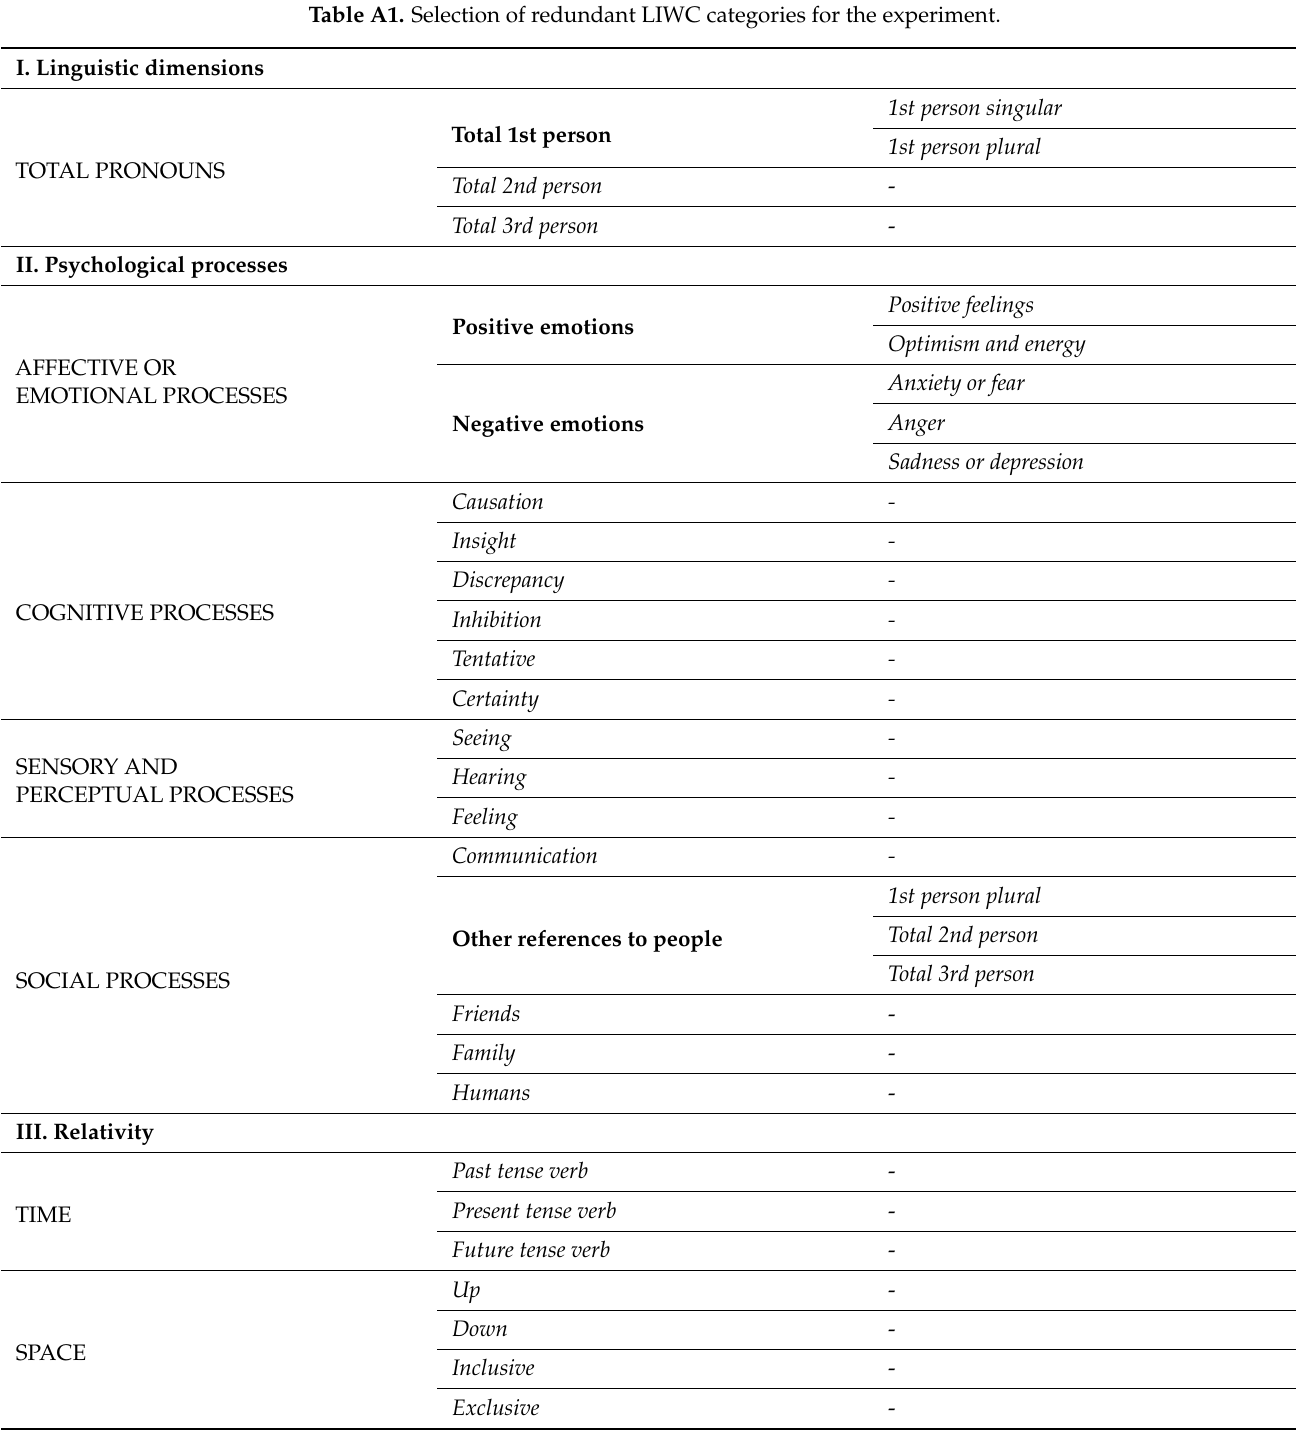
Table A1. Selection of redundant LIWC categories for the